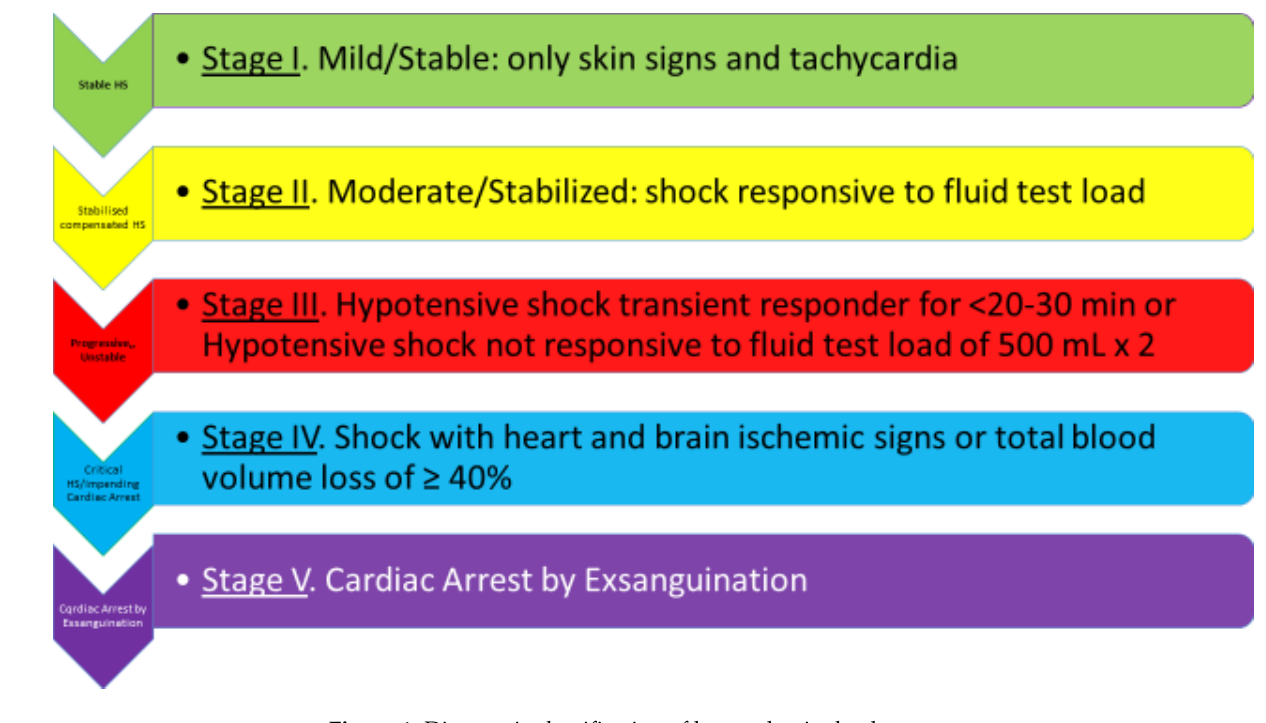
Figure 1. Diagnostic classification of hemorrhagic shock.